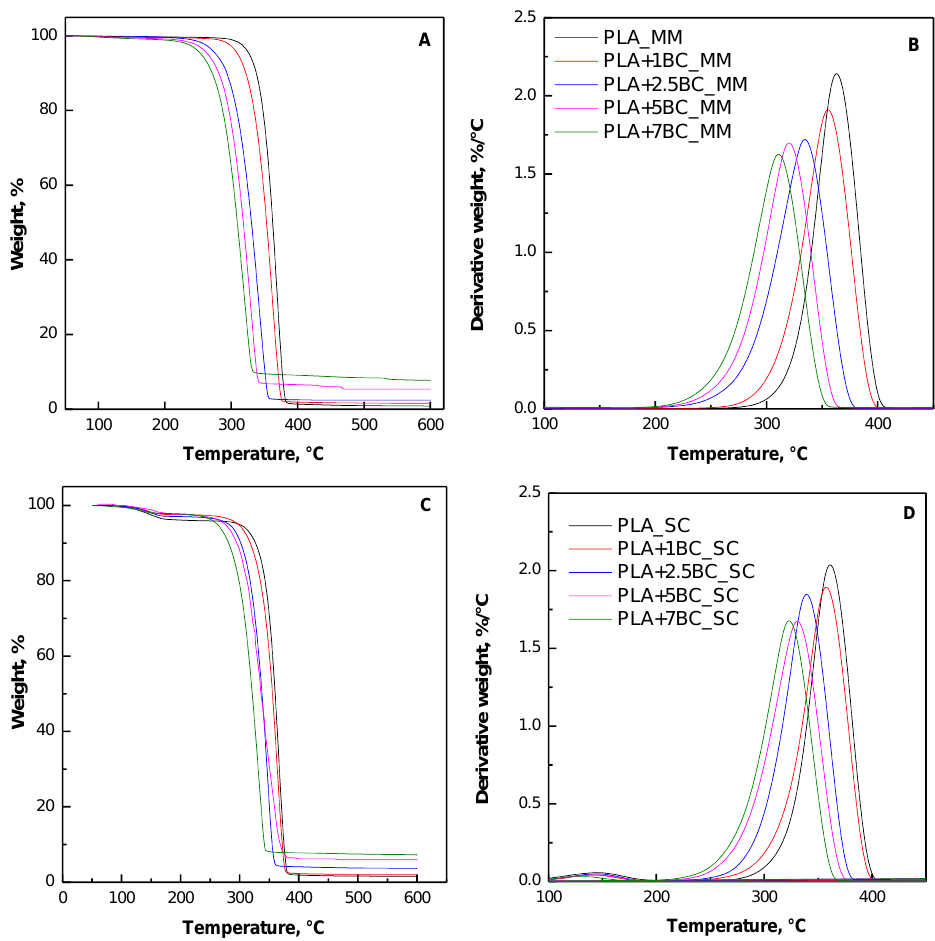
Figure 6. Thermogravimetric (TG) ( A , C ) and dTG ( B , D ) curves for neat PLA and its composites obtained through melt mixing ( A , B ) and solvent casting ( C , D ). Table 2. Thermogravimetric analysis (TGA) results in N2 for neat PLA and BC-containing composites.